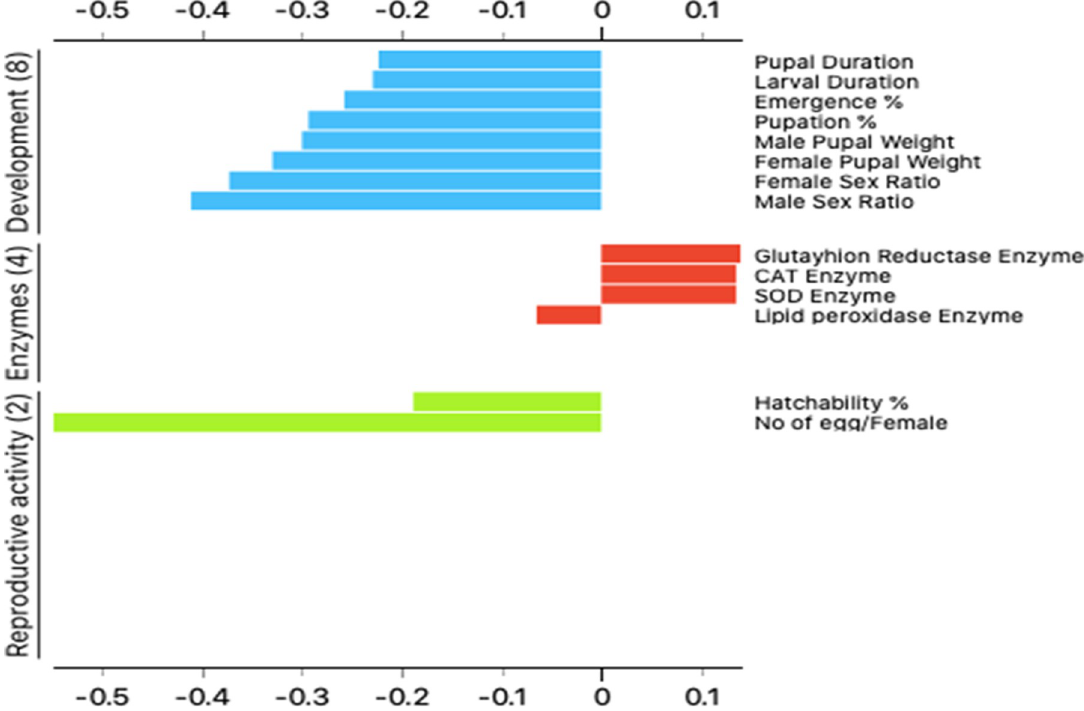
Fig 3. Plot of Silhouette analysis values for clustering of reproductive activity, enzymes and developmental variables. On the y-axis each cluster are ordered by decreasing silhouette value. The silhouette value can range between − 1 and 1.